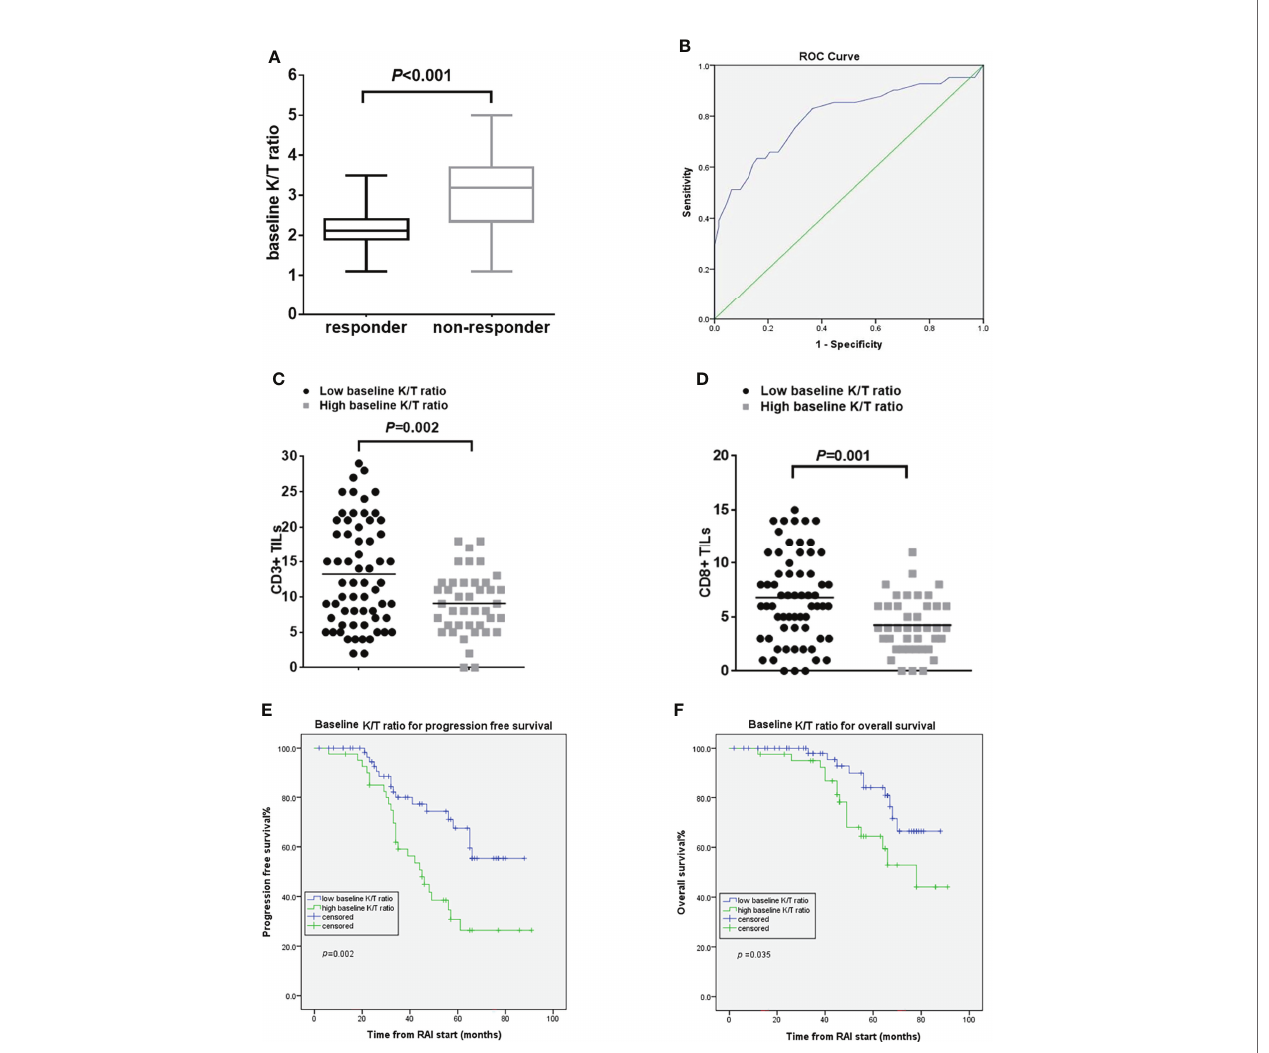
FIGURE 2 | Pre-RAI K/T ratio and treatment outcomes. (A) the pre-RAI K/T ratio according to the response to RAI treatment (B) ROC curve for pre-RAI K/T ratio in dmDTC patients (C) association of baseline K/T ratio with the number of CD3 + TILs (D) association of baseline K/T ratio with the number of CD8 + TILs (E) PFS curves of the dmDTC patients according to pre-RAI K/T ratio (F) OS curves of the dmDTC patients according to pre-RAI K/T